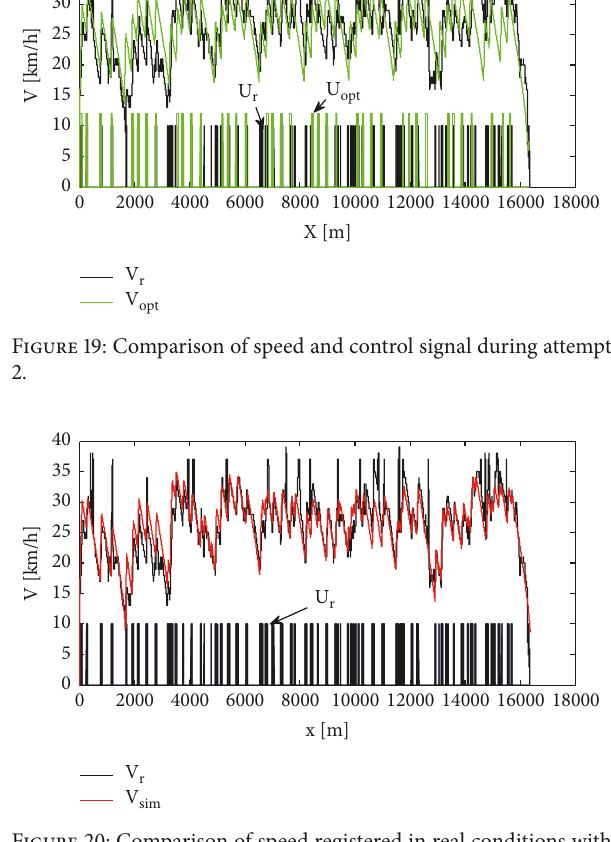
Figure 20: Comparison of speed registered in real conditions with the speed determined by computer